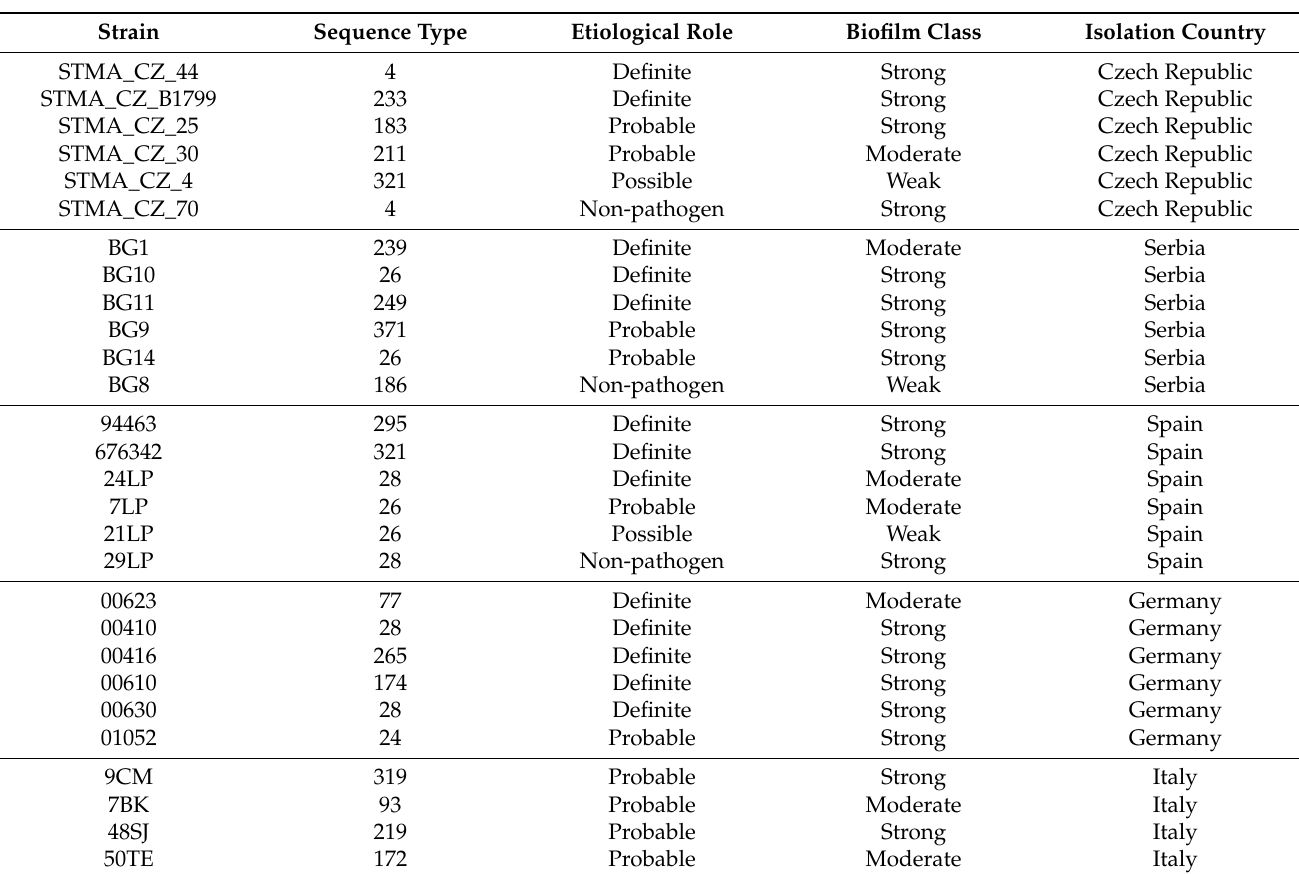
Table 2. S. maltophilia strains chosen for Multilocus Sequence Typing (MLST) analysis. Strains were selected as rep- resentative for different etiological roles (according to CDC guidelines [22]), biofilm formation classes (according to Stepanovi´c et al. [24]), and isolation